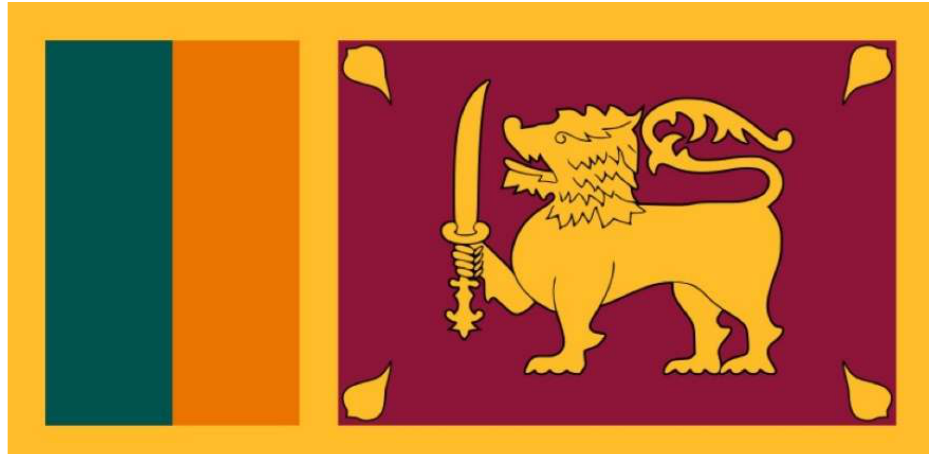
Figure 5. Flag of Sri Lanka featuring Sinhabahu, the legendary